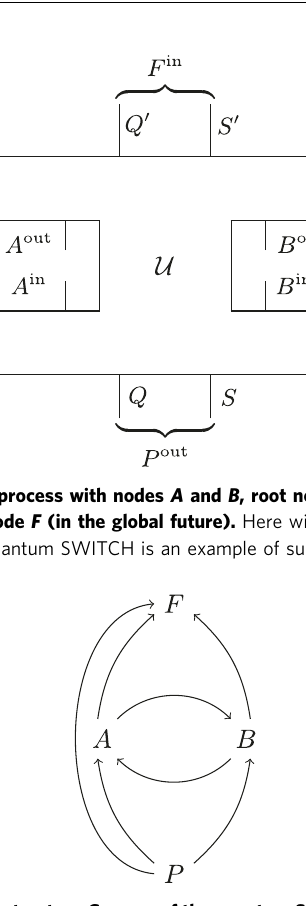
Fig. 4 The causal structure G SWITCH of the quantum SWITCH. Any unitary process of the form as in Fig. 3 has a causal structure that is a subgraph of G SWITCH